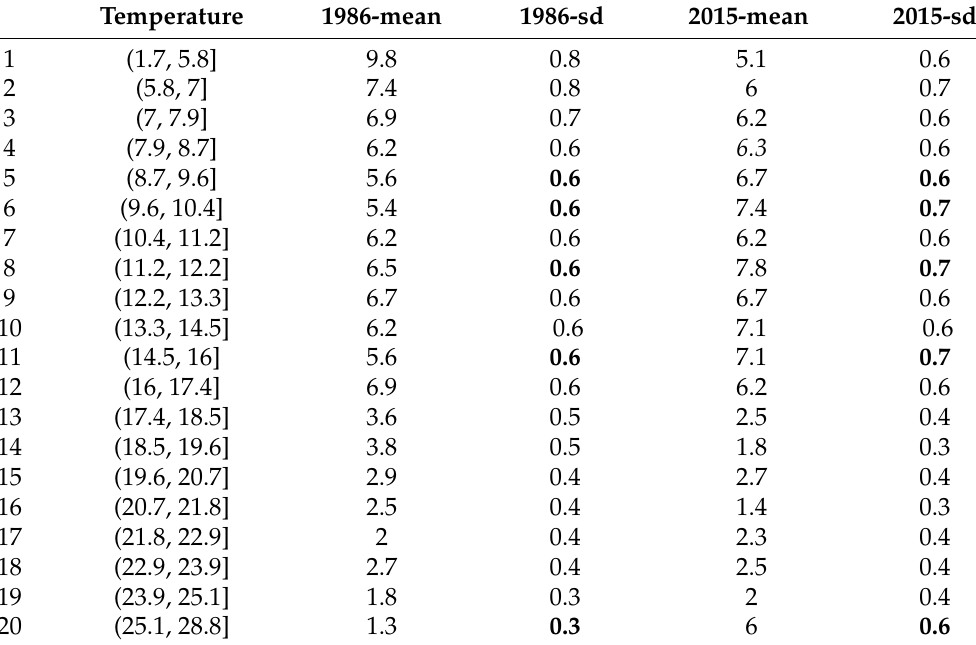
Table 6. Data Simulated: Mean and standard deviation of 1000 meteorological bootstrapped observa- tions of Campania for temperature classes in 1986 and 2015. The standard deviations (sd) highlighted in bold are those of the critical temperature